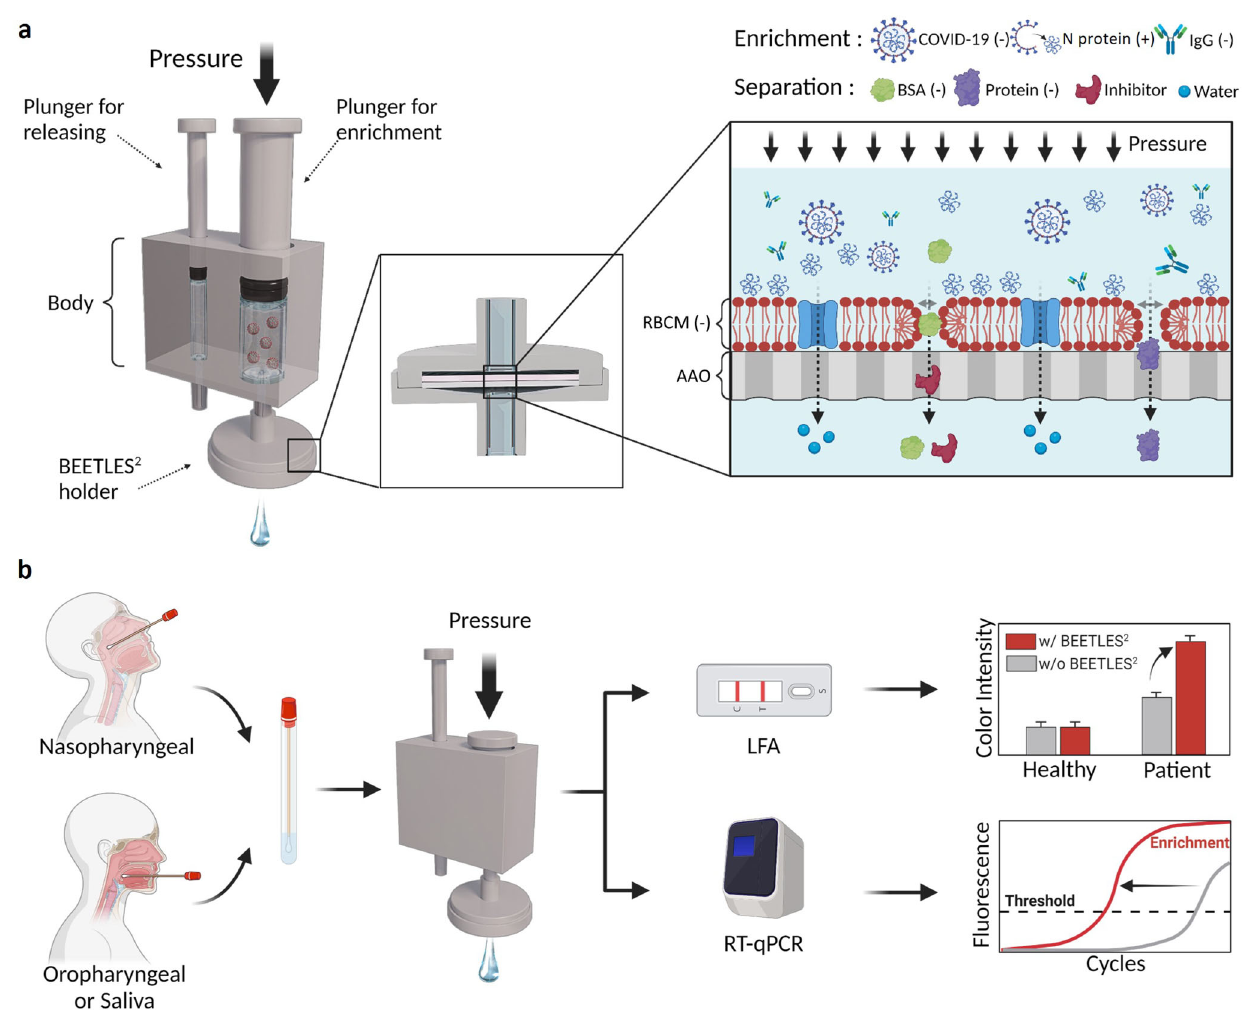
Fig. 1 | Illustration of BEETLES 2 for COVID-19 diagnostics. a BEETLES 2 , a hybrid fi lterconsisting ofRBCMon anAAOmembrane, haspermselectivityand tunability that enable biomolecules to enrich with a separation function. b Assay with BEE- TLES 2 for immunoassay and molecular assay. Cartoons in panels a, b were created